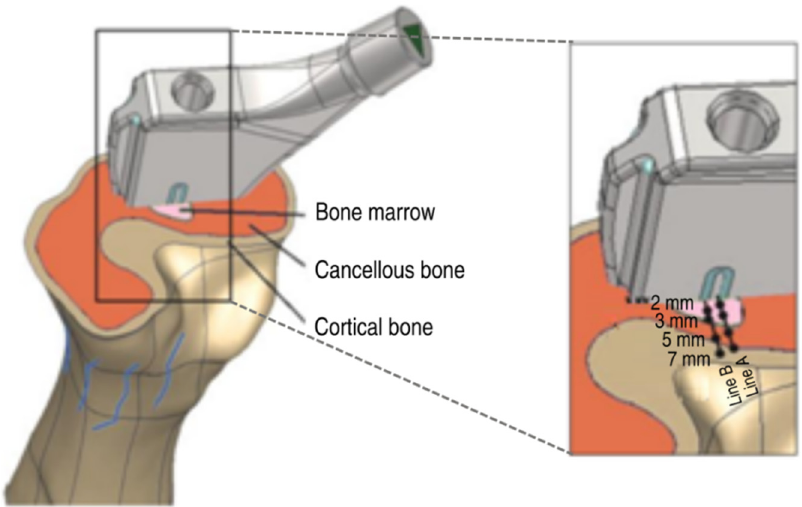
Figure 1. CAD model of the porcine femur with the modified total hip stem. The inset displays the measurement points at the cross section of the porcine bone along two lines. The points are allocated on two parallel lines at 2, 3, 5, and 7 mm from the first electrode (line A) and from the interface between insulator and implant (line B).